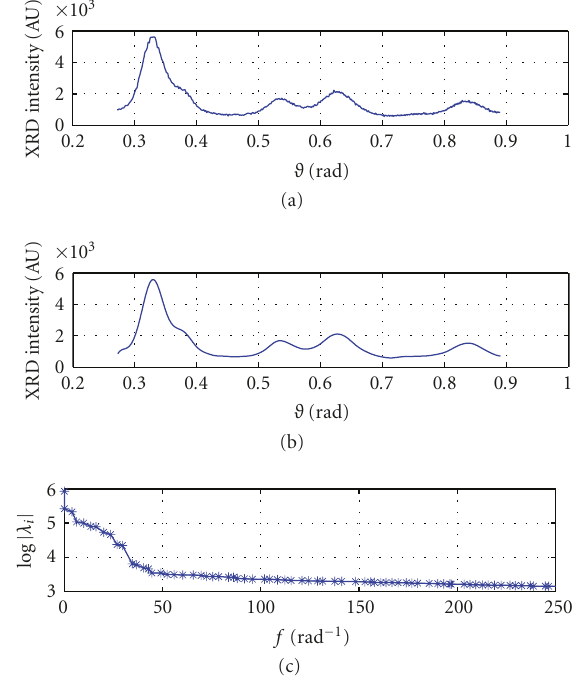
Figure 6: Au real sample of 3.2 nm: (a) noisy (NSR = 2 . 3%) XRD intensity profile as a function of the scattering angle ϑ ; (b) filtered XRD intensity profile; (c) amplitudes of eigenvalues λ k versus fre- quency f k , k = 1, ... , q